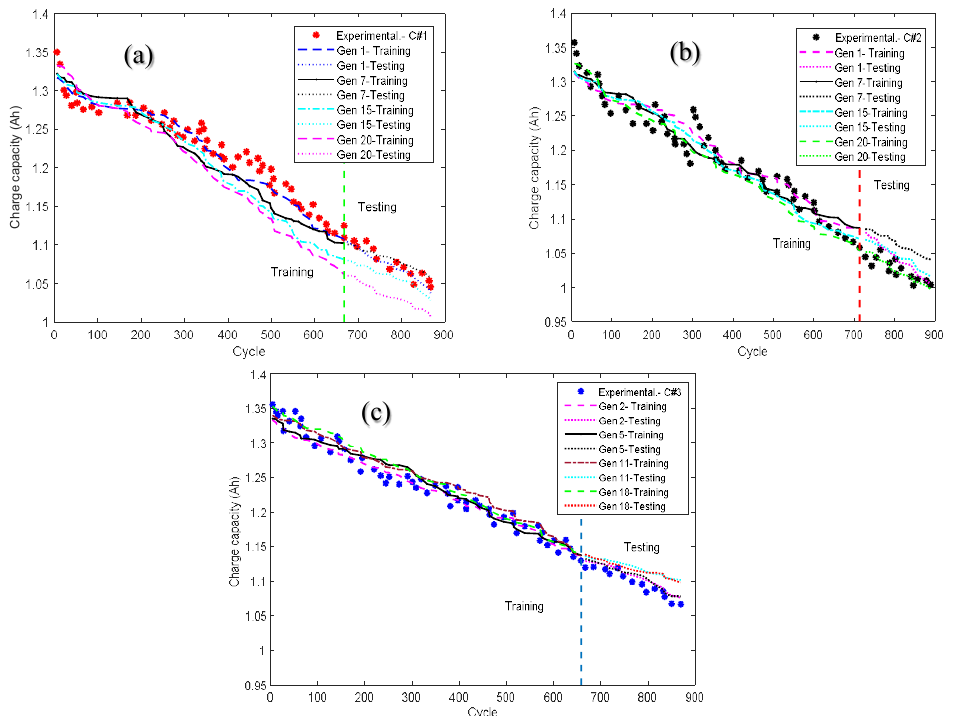
the testing dataset.